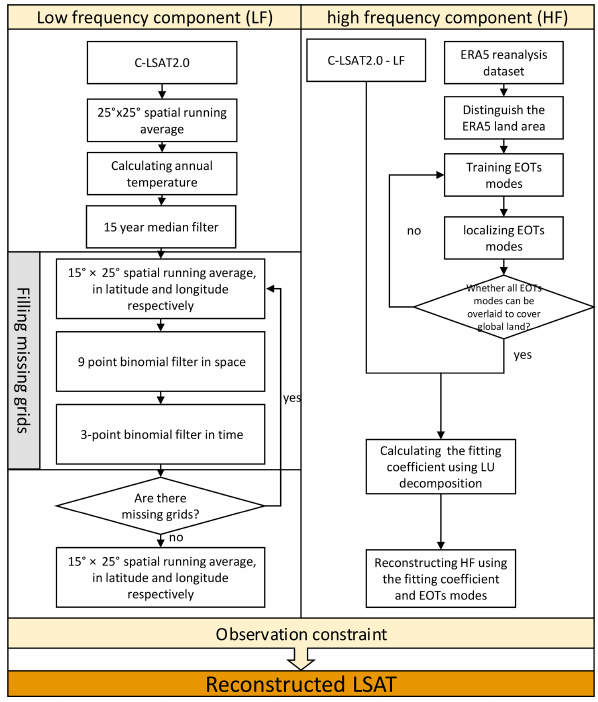
Figure 2. Schematic diagram of the LSAT reconstruction process.